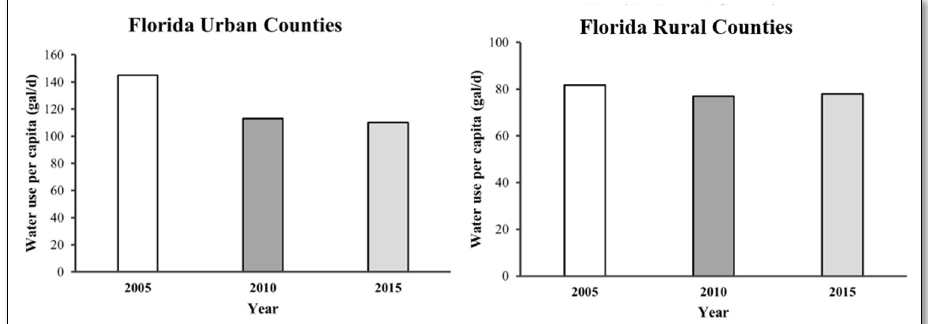
Figure 9. Comparison within counties.